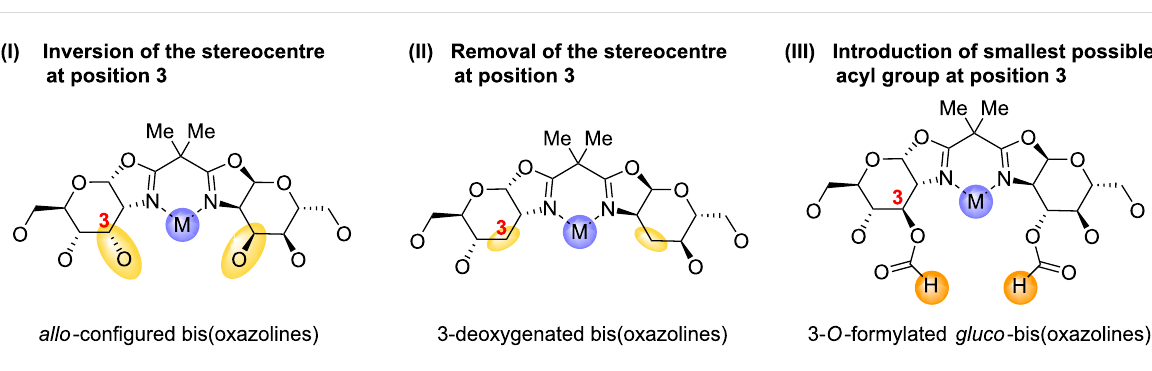
Figure 1: Planned modifications at pyranose position 3 of carbohydrate